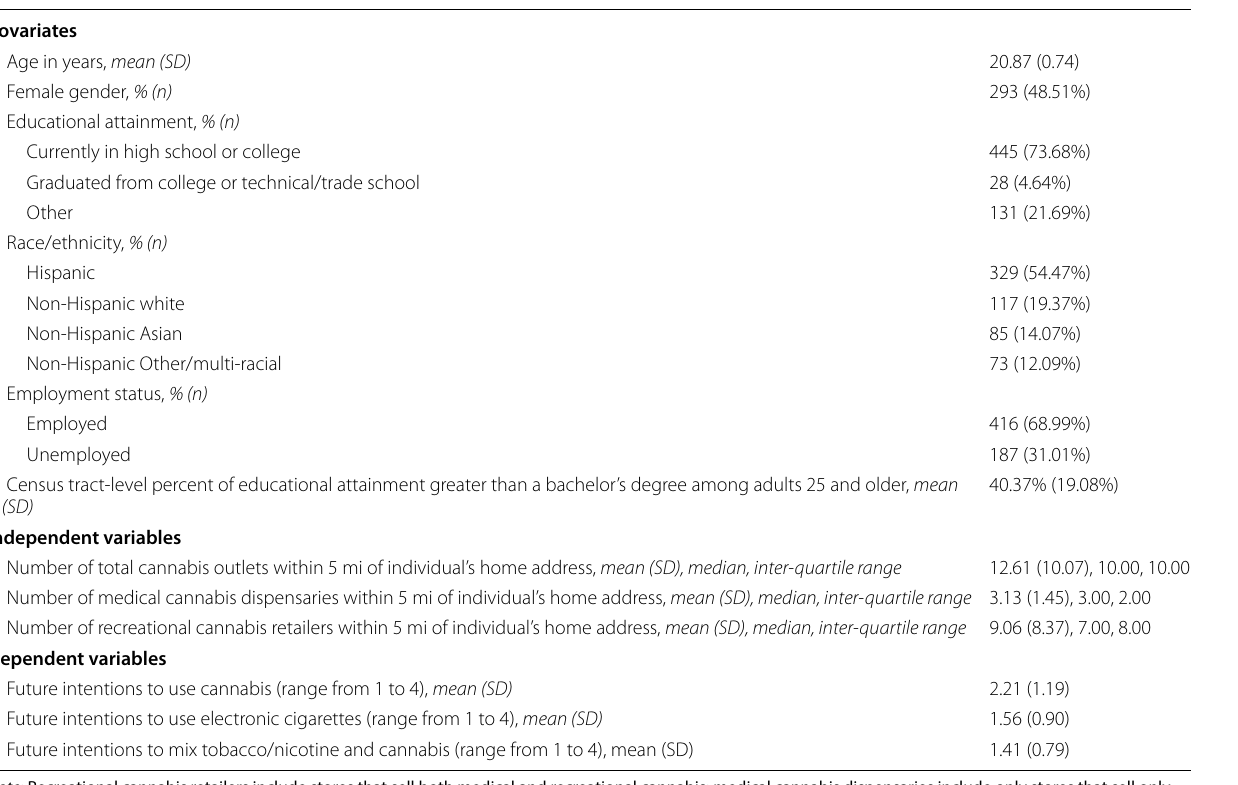
Table 1 Sociodemographic and cannabis-related characteristics of n